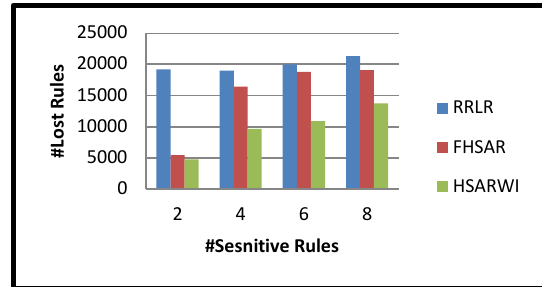
Figure 2. Lost rules in chess with MST = 0.88 and MCT =